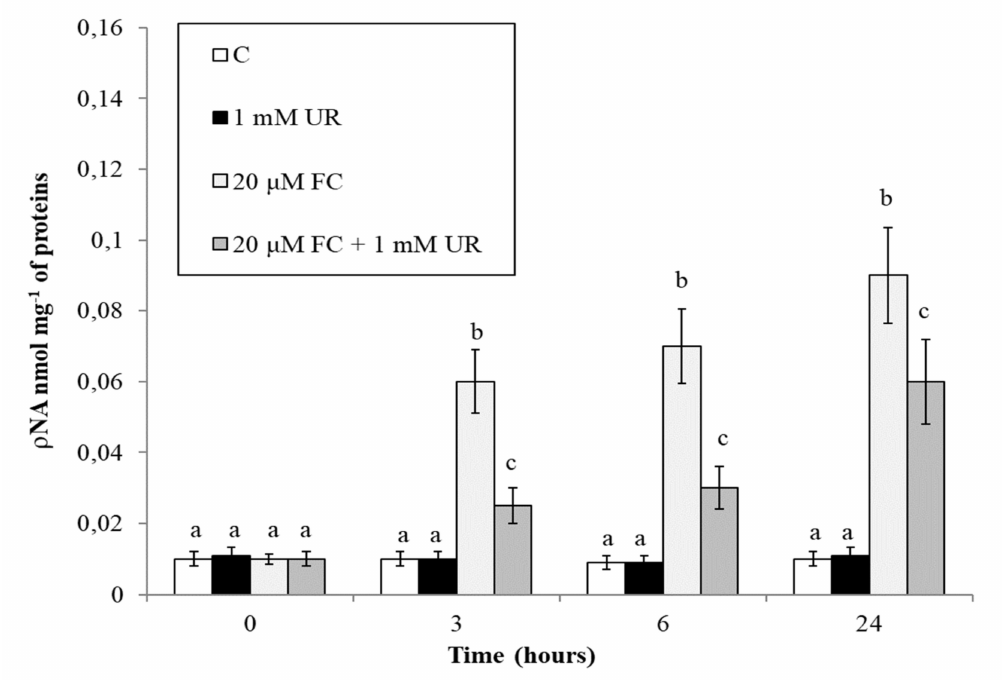
Figure 6. Effect of FC and urate on caspase-3-like activity. Means ± SD (n ≥ 6) are shown. Different letters show significant differences among treatments at each time (Tukey HSD test, p ≤